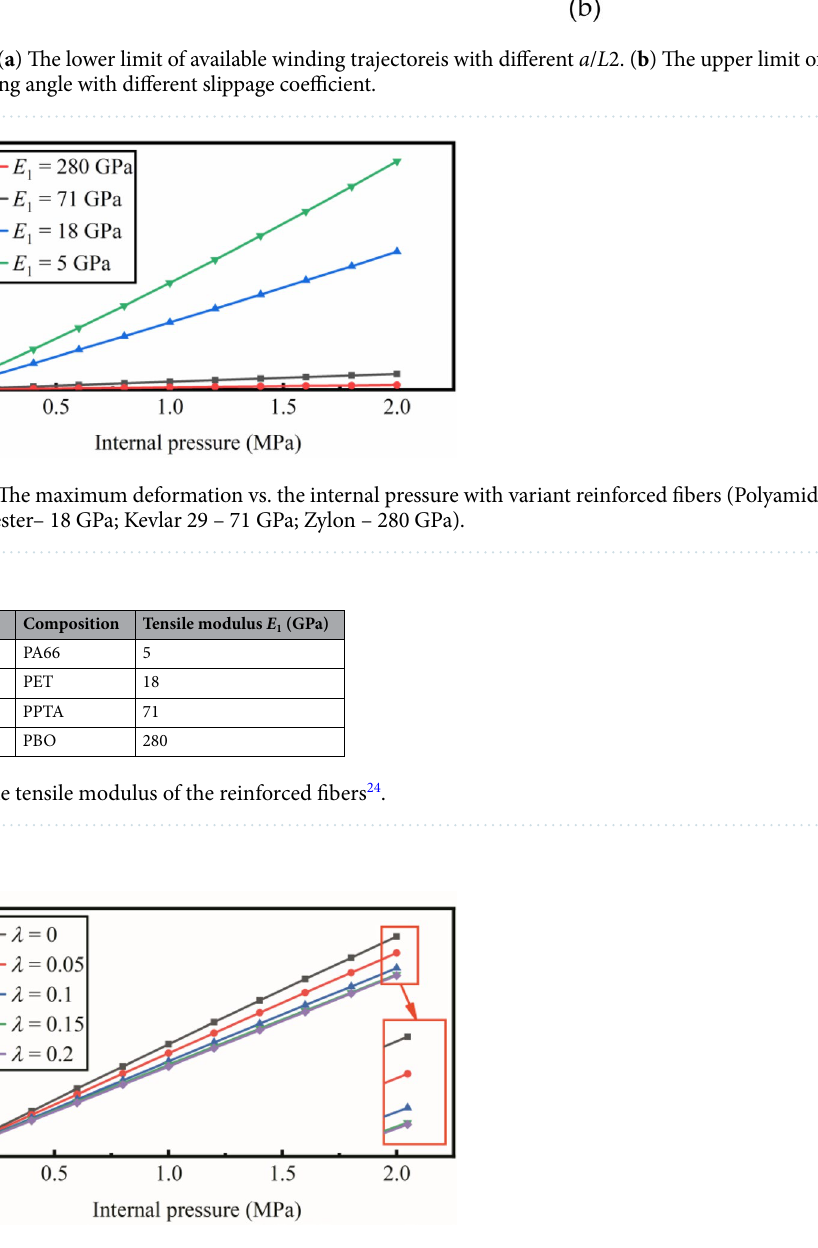
Figure 12. Maximum deformation vs. the internal pressure with the slippage coefficient increased form 0 to